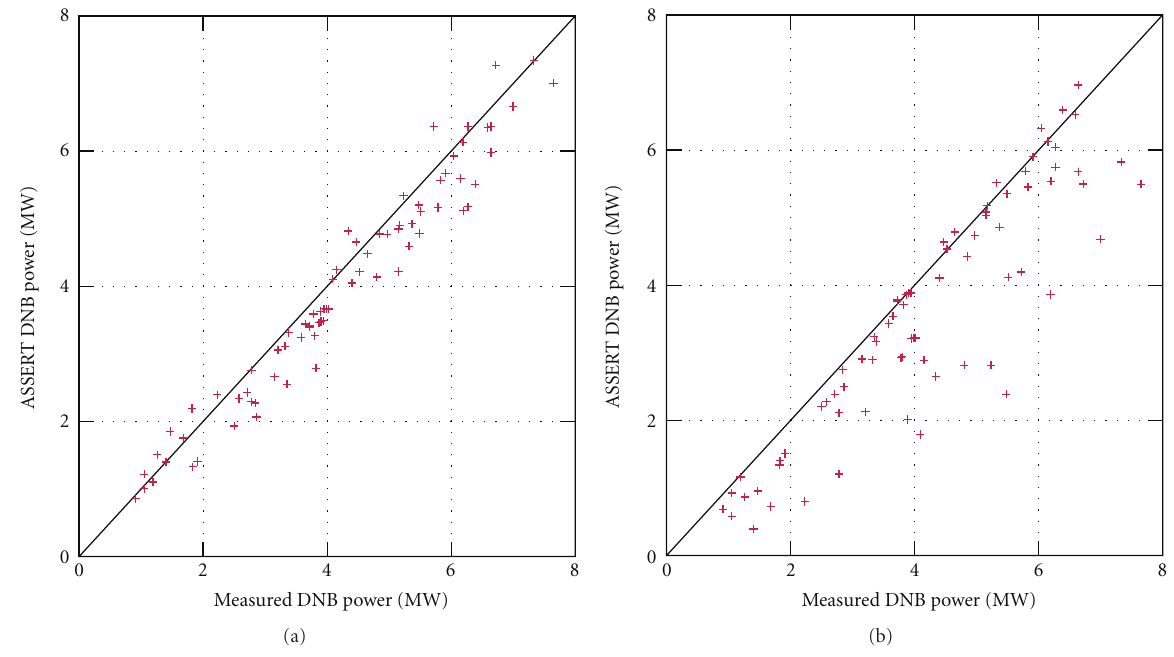
Figure 18: Steady state departure from nucleate boiling results for test series A2 using the Biasi correlation (a) and Weisman correlation (b). The estimated uncertainty on the power measurements is 2 σ exp = 2% and is not illustrated in the figure.